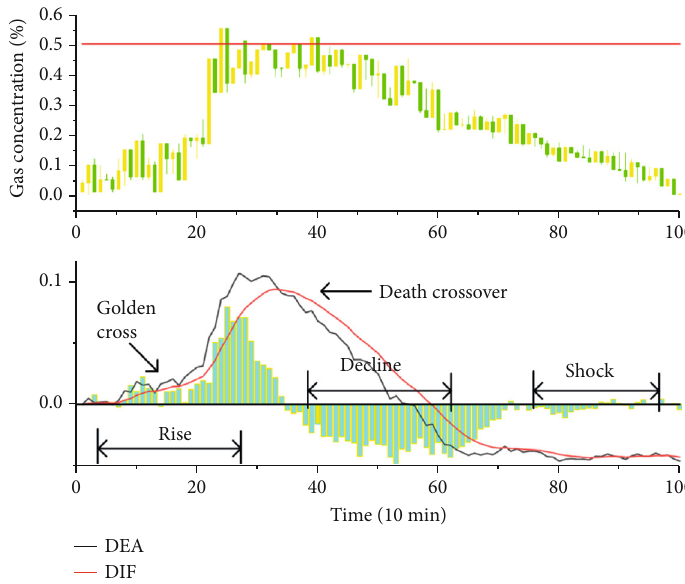
Figure 7: MACD index of gas